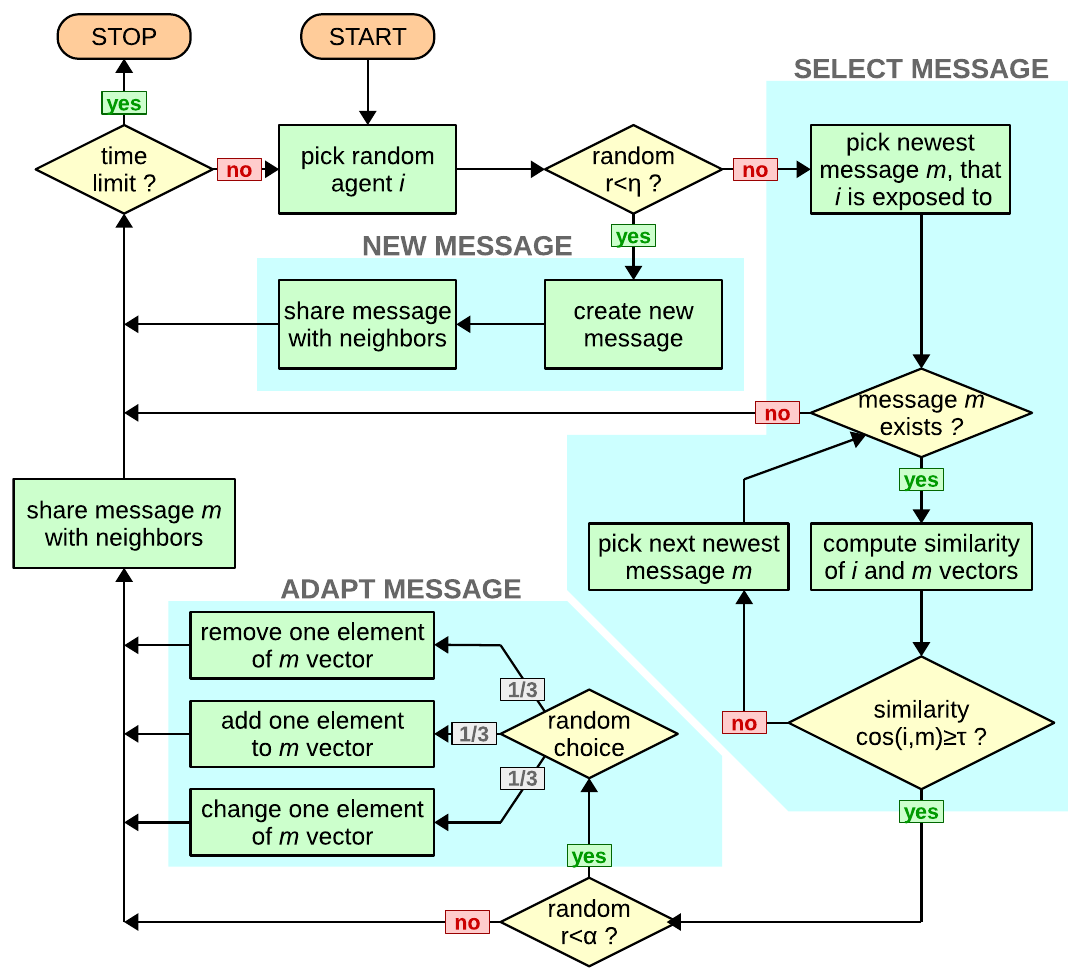
Figure 8. Flowchart of the algorithm for creation, sharing and modification of messages in our